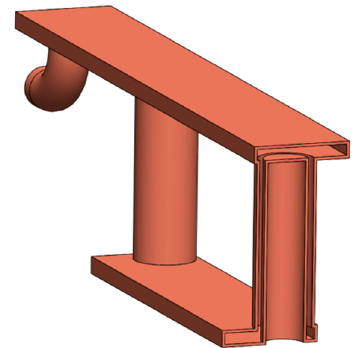
Figure 12. Partial view of the 3D model with final design changes applied to the future manifold header prototype.